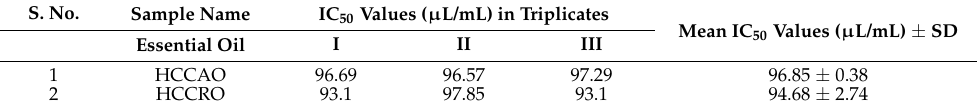
Table 11. IC 50 value of inhibition of root length of HCCAO and HCCRO.